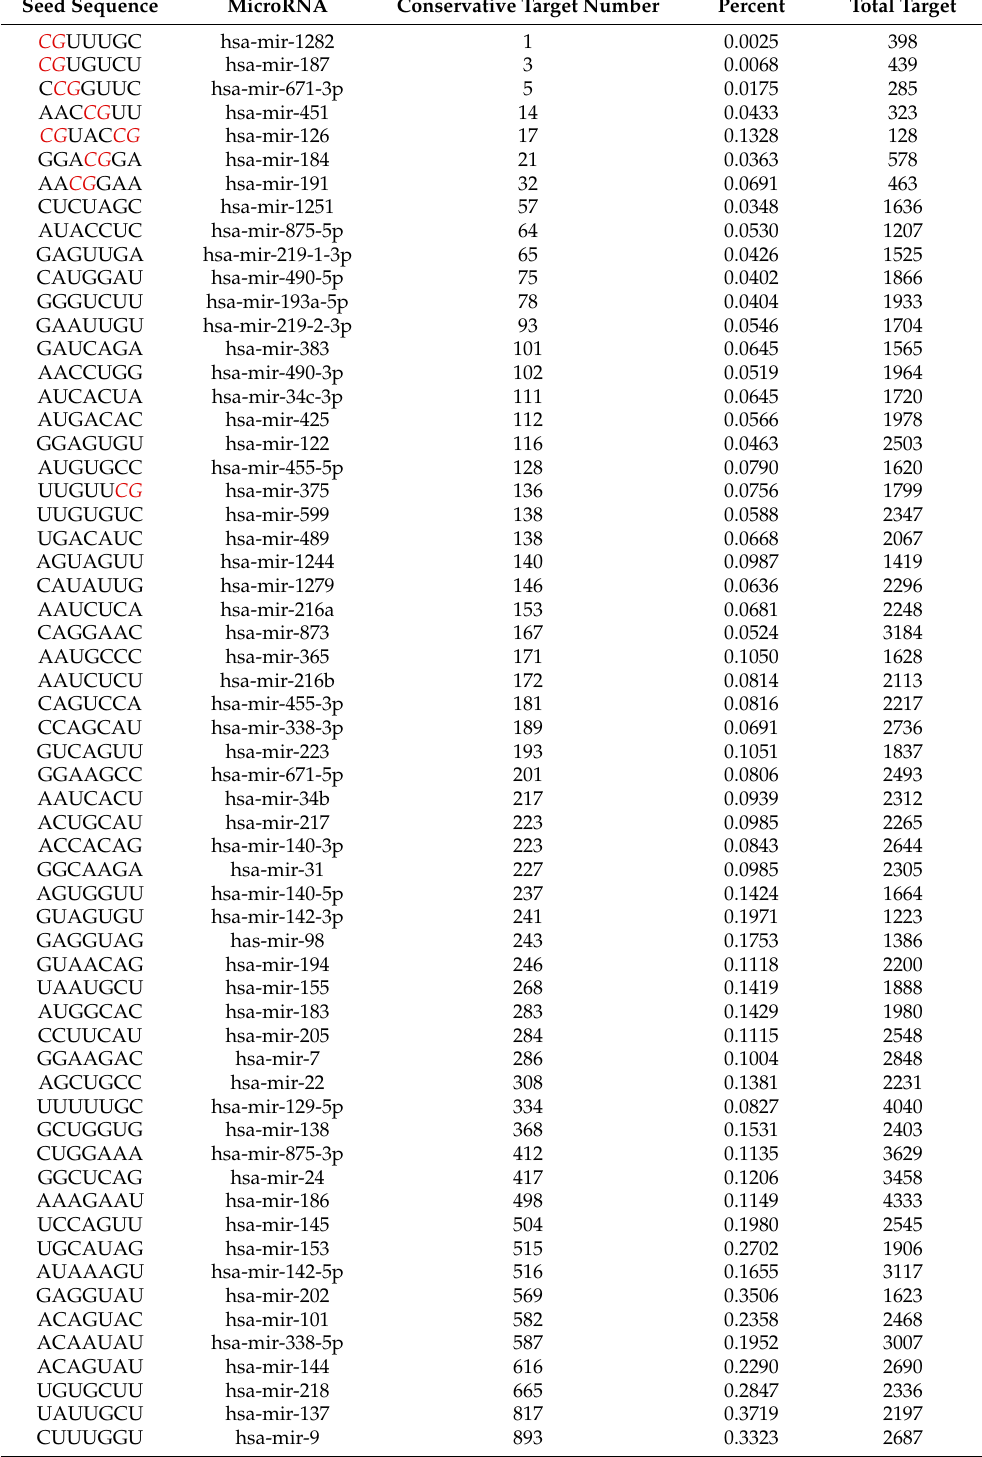
Table 1. Vertebrate conservative miRNA TargetScan